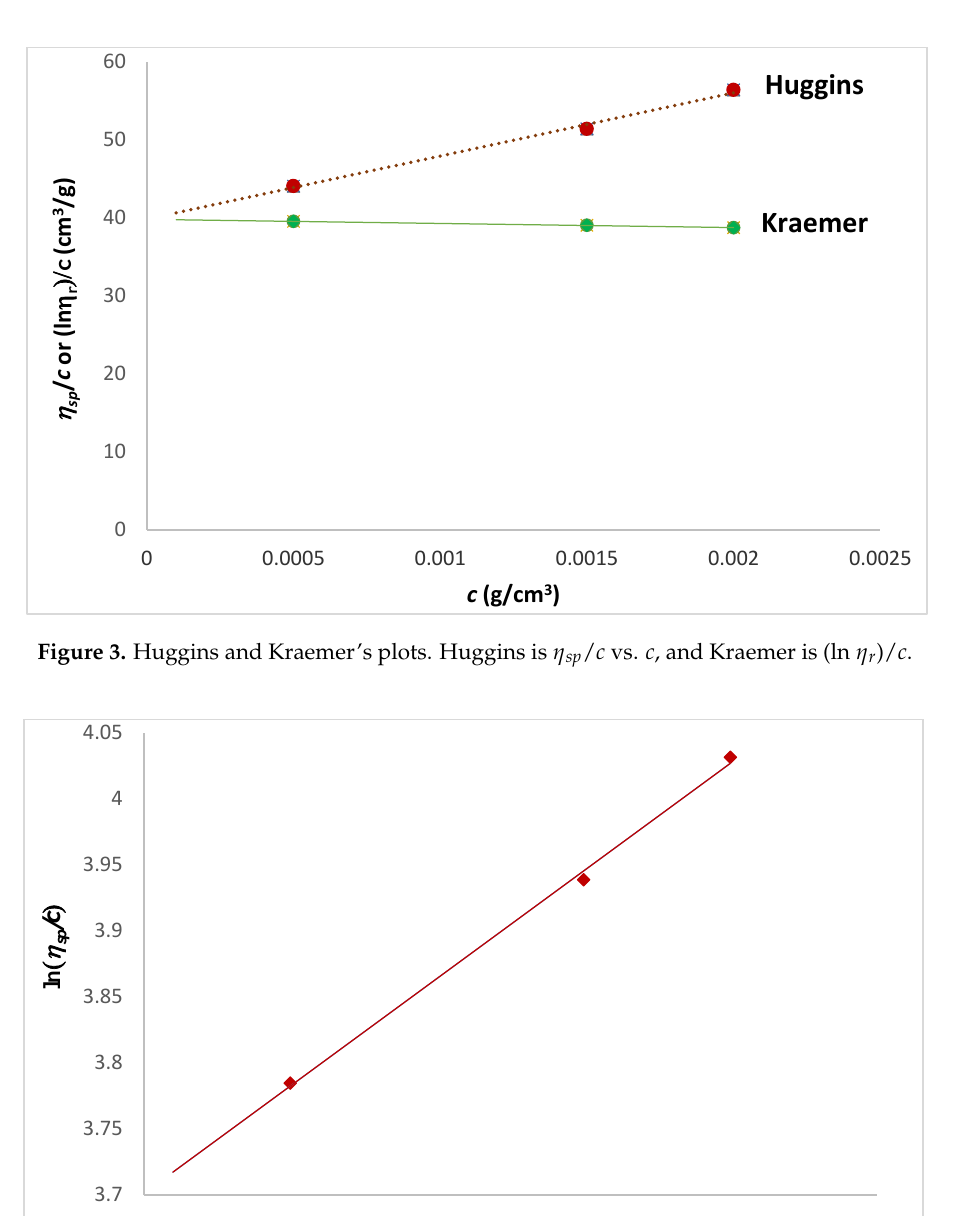
Figure 4. Martin’s plots, ln η sp / c vs. c .